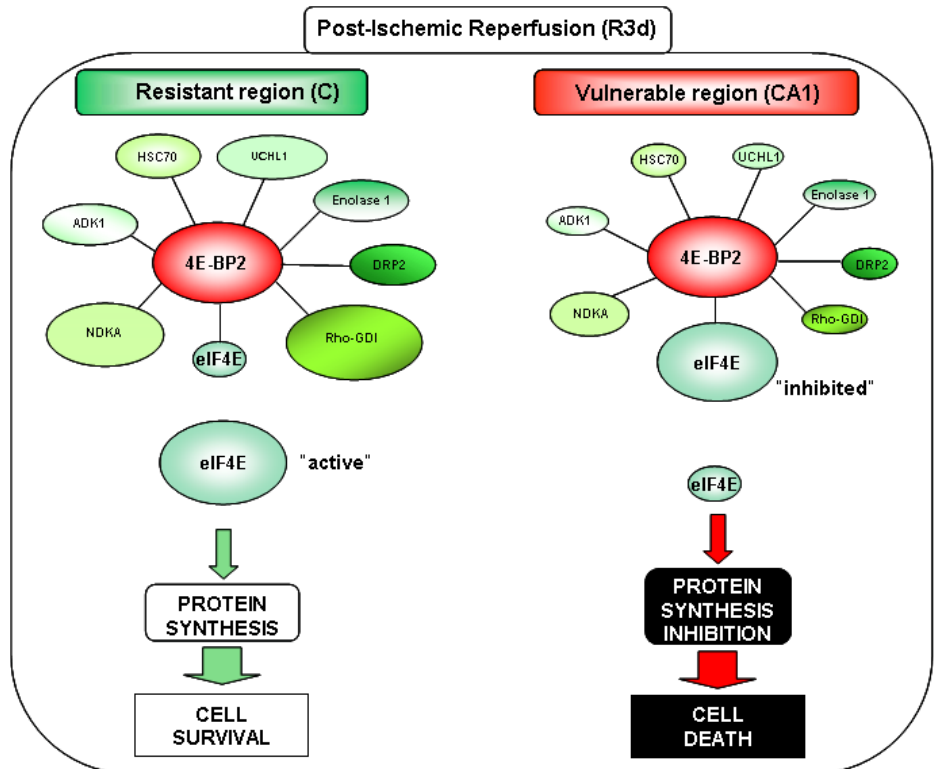
Figure 6. 4E-BP2-interacting proteins as pivotal modulators in the cellular response to ischemia-reperfusion stress. Proposed model of 4E-BP2 regulation in resistant and vulnerable regions in brain ischemia: 4E-BP2-interacting proteins would compete with eIF4E, releasing this factor when they increase their association with 4E-BP2 (e.g., in the cerebral cortex, C), promoting protein synthesis and cell protection to ischemia-reperfusion stress. Conversely, a decreased of 4E-BP2-interacting proteins, would allow a higher eIF4E/4E-BP2 association with the subsequent protein synthesis inhibition and cell death.